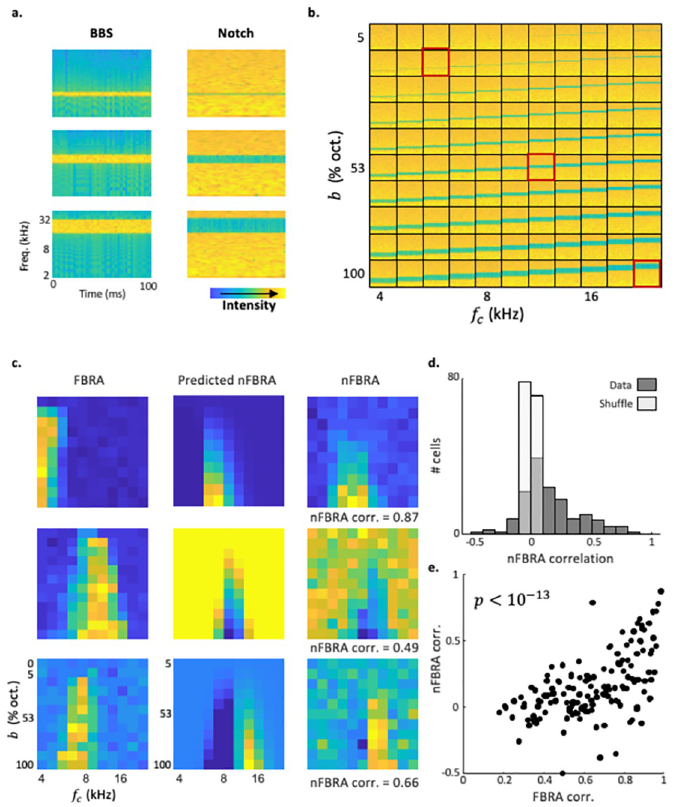
Fig 4. Validation of the MRW model using notch stimuli. a. Spectrograms of 3 example BBS (left) and their respective notch stimuli (right). b. Spectrograms of all presented notch stimuli sorted based on inverse bandwidth (Y axis, b ), and central frequency (x axis, f ). The 3 stimuli from ‘a’ are marked in red. c. Left: FBRAs of 3 example neurons c from 3 different mice. Middle: nFBRAs of the same neurons as predicted by the MRW fit for BBS. Right: nFBRAs of the same neurons. d. Distribution of nFBRA correlation values for real and shuffled data ( p < 10 − 10 , paired student’s t- test). e. nFBRA correlation vs. FBRA correlation for all neurons (n = 149, Pearson correlation, p < 10 − 6 ).